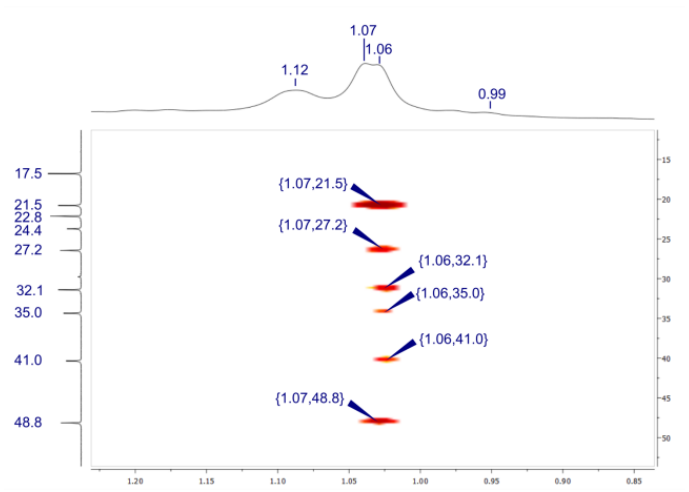
Figure 3. Fragment of 1 H– 1 H COSY NMR spectrum of 2 in pyridine- d 5 .